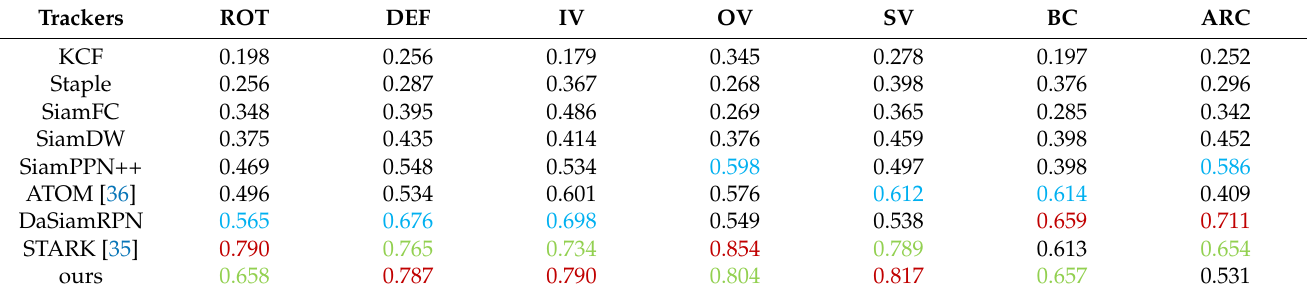
Table 7. Comparisons on the Ox-UvA [33] long-term dataset. The best three results are marked in red, green, and blue bold fonts, respectively.